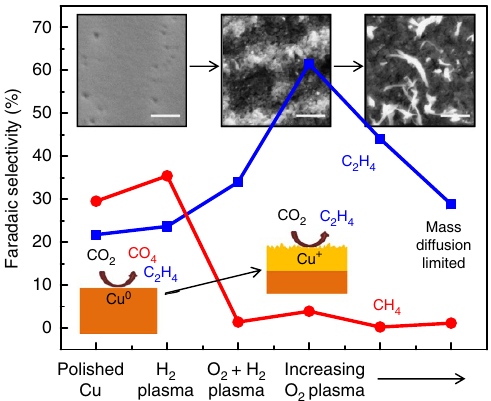
Figure 6 | Summary of hydrocarbon selectivity of plasma-treated Cu foils. From left to right, the insets show SEM images of the low surface area H 2 plasma-treated metallic Cu foil, the O 2 20W 2min plasma-treated Cu foil with optimal ethylene selectivity, and the high surface area nanoneedles on the O 2 100W 10min oxidized sample after the reaction (500nm scale